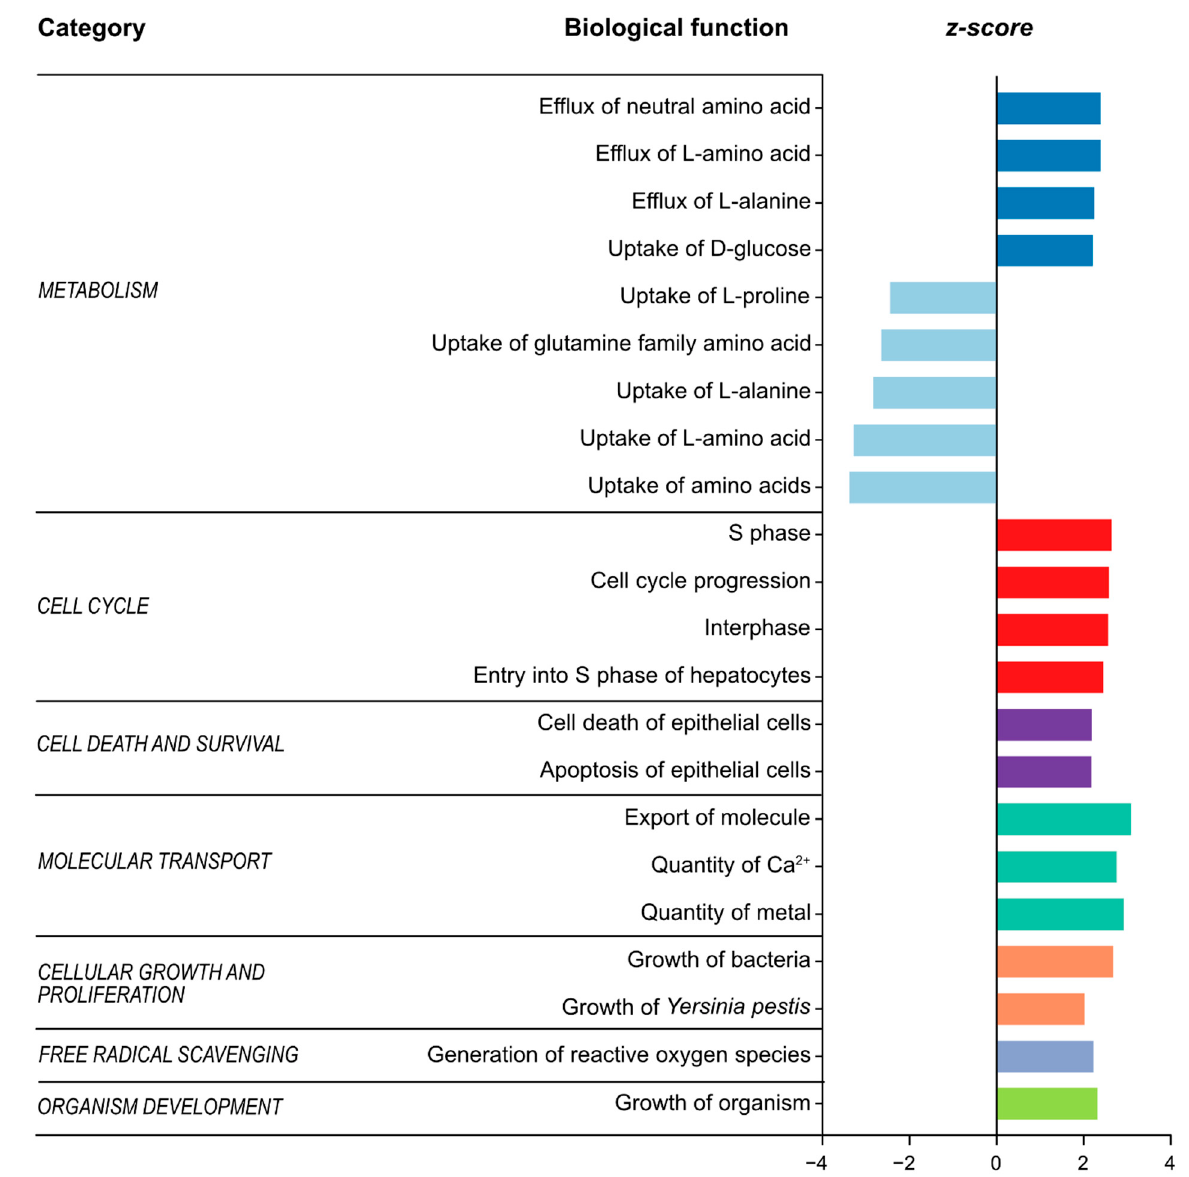
Figure 4. Significantly enriched biological functions predicted to be associated with changes in metabolites in patients with IBS compared to healthy subjects. The bar plot represents 22 biological functions predicted to be altered in IBS patients with significant activation Z-score > 2 or < − 2 identified by IPA core analysis. Z-scores > 2 or < − 2 indicate predicted decrease or increase, respectively. The analysis used a total of 35 metabolites ( p value < 0.05). Each bar denotes a different biological function where each colour corresponds to a simplified category.